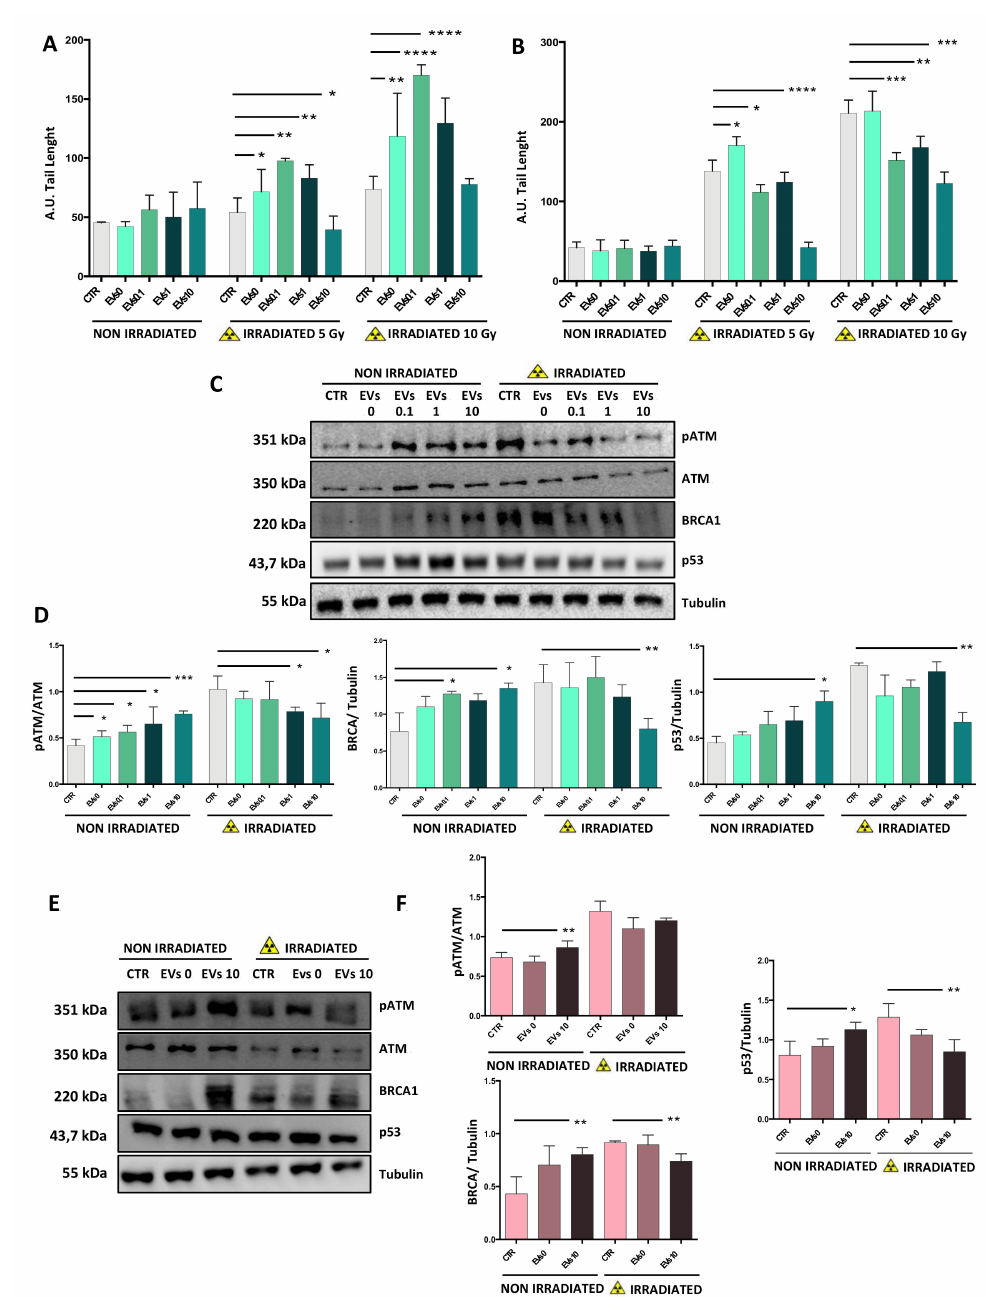
Figure 5. EVs protect cells from radio-induced DNA damage. Neuroblastoma cells were pre-treated for 1 h with EVs0, EVs0.1, EVs1, and EVs10, and then exposed/mock exposed to X-rays. SH-SY5Y cells were processed for Comet Assay after 2 h ( A ) and 24 h ( B ); ( C ) pATM (S1981), ATM, BRCA1, and p53 protein levels in SH-SY5Y cells were determined by Western blotting using Tubulin as loading control. ( D ) Relative densitometric analysis of the above-mentioned proteins. ( E ) pATM (S1981), ATM, BRCA1, and p53 protein levels in SK-N-BE cells were determined by Western blotting using Tubulin as loading control. ( F ) Relative densitometric analysis of the above-mentioned proteins. Data are expressed as means ± S.D. (n = 4, * p < 0.05, ** p < 0.01, *** p < 0.001, **** p < 0.0001 vs. 6